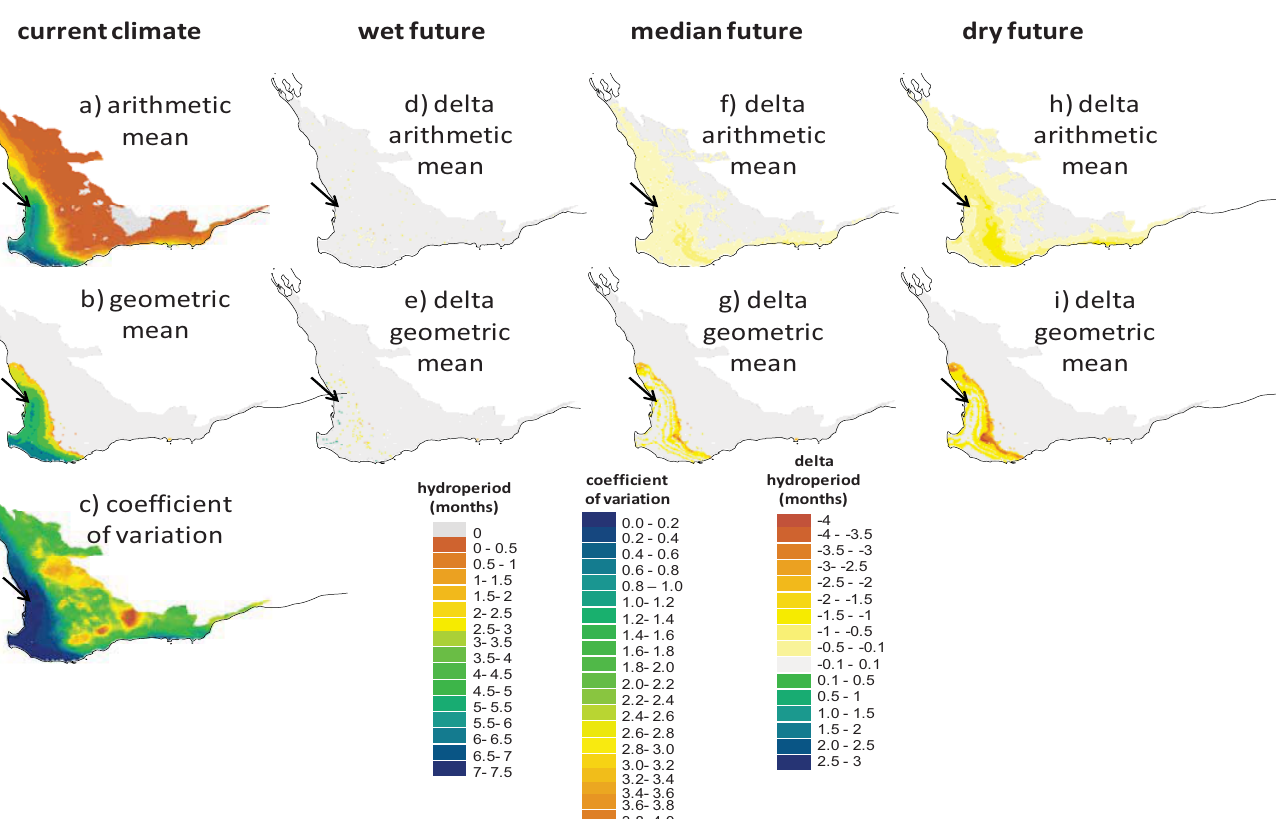
Figure 5. Screening maps of the Southwest Australia Ecoregion showing ( a ), the arithmetic mean, ( b ) the geometric mean and ( c ) the coefficient of variation of the hydroperiod (in months) predicted by WET-R in the period 1990–2009. Models are driven by current climate (1990–2009: AWAP data, a – c ) and also indicated are the impacts on the hydroperiod of three future climates for 2030 where air temperatures increase by 0.7–1.3 °C and total annual rainfall decreases by 1%–14% (future scenario—current scenario; d – i ). The black arrow indicates the location of the wild